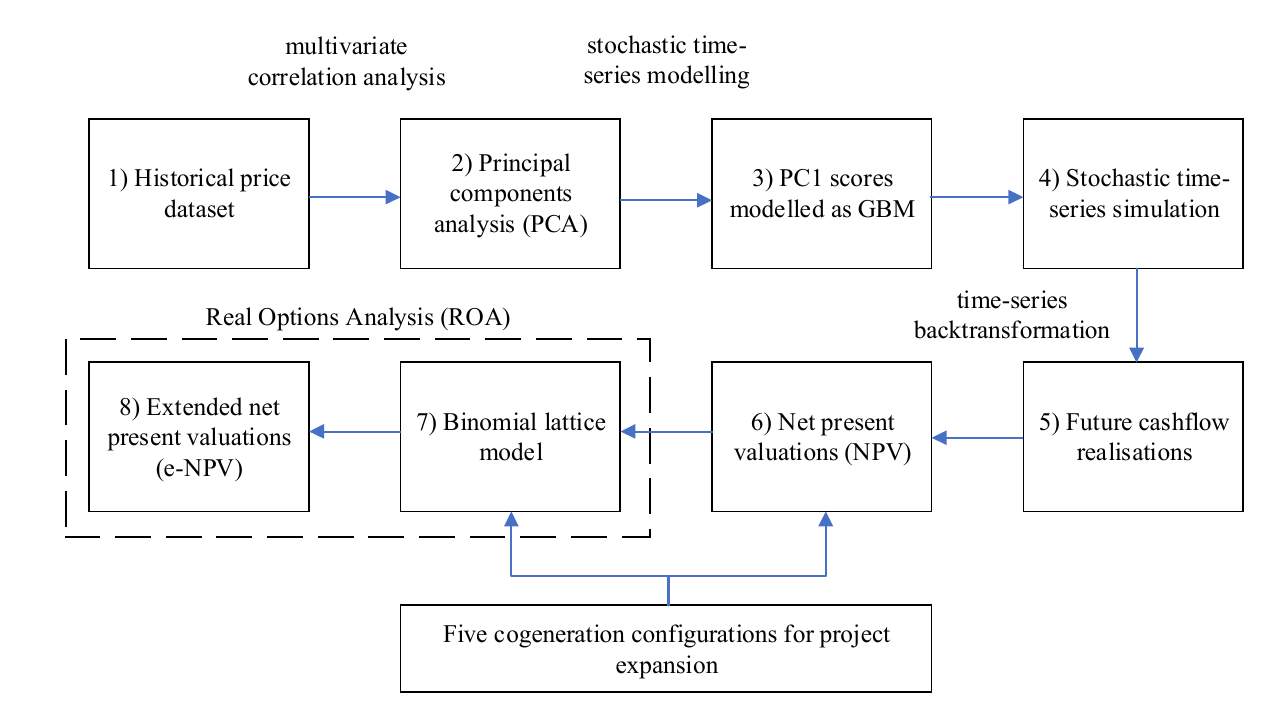
Figure 3. A flowchart depicting the multidimensional risk-based valuation methodology for the cogeneration system configurations assumed in this study.